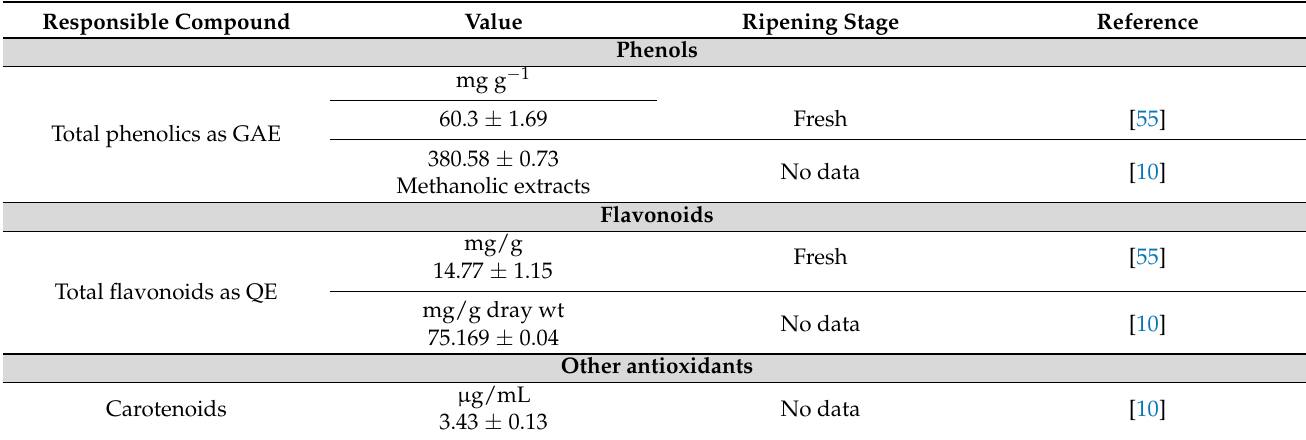
Table 10. Antioxidant compounds of Mespilus germanica L. leaves.